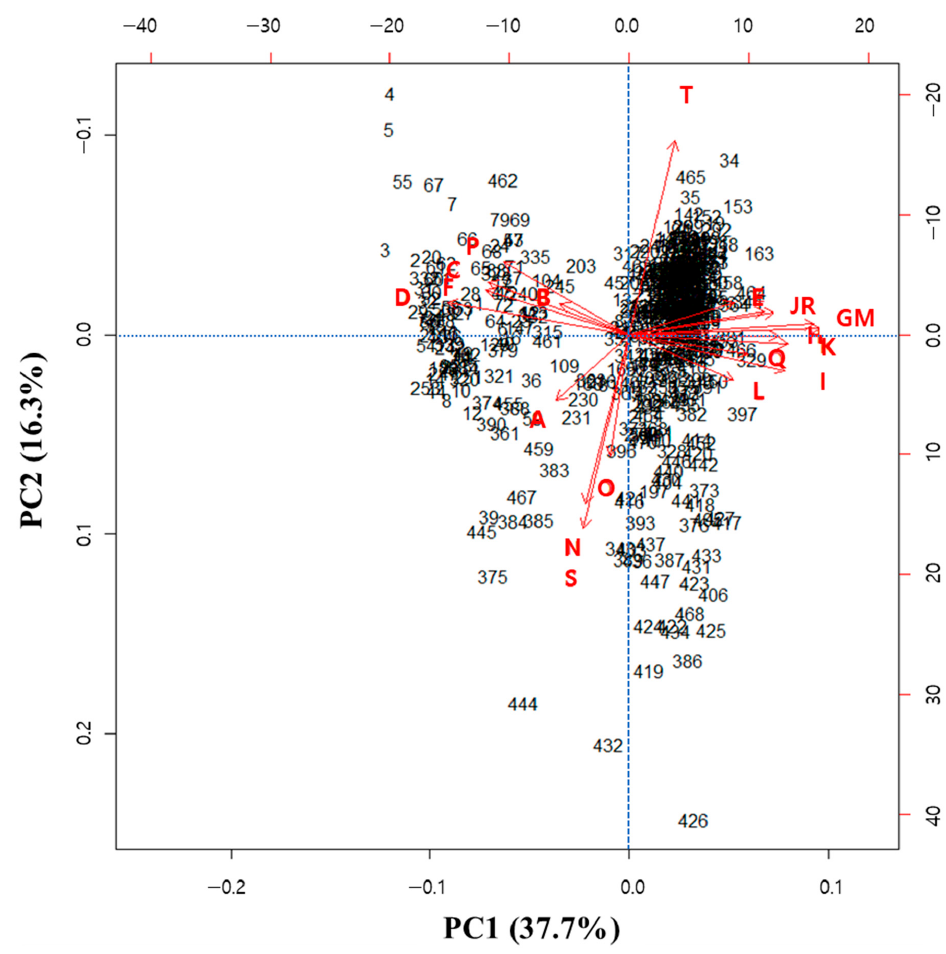
Figure 2. Scatterplot of principal component 1 (PC1: 37.7%) and principal component 2 (PC2: 16.3%) based on 20 seed composition traits of 468 black soybean germplasms with green cotyledons, in-